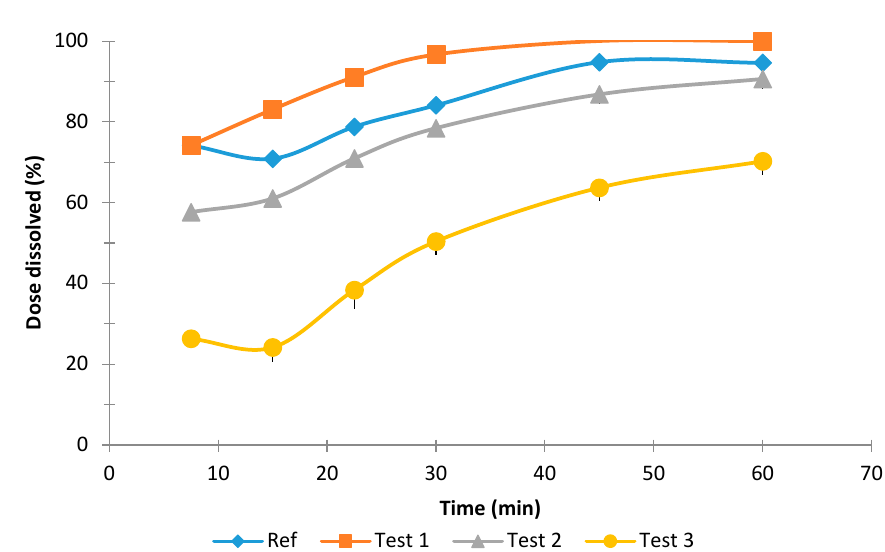
Figure 5. Mean dissolution results obtained with the rotational paddle dissolution equipment at 6.8 pH and 0.2% w / v SDS. Table 3. Similarity factor f2 calculated for the three test formulations at the four different dissolution conditions with the two pharmacopoeia dissolution methods.